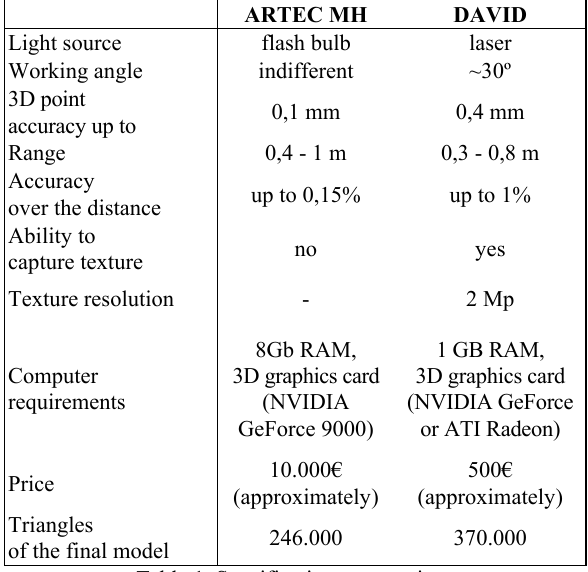
Table 1. Specifications comparison